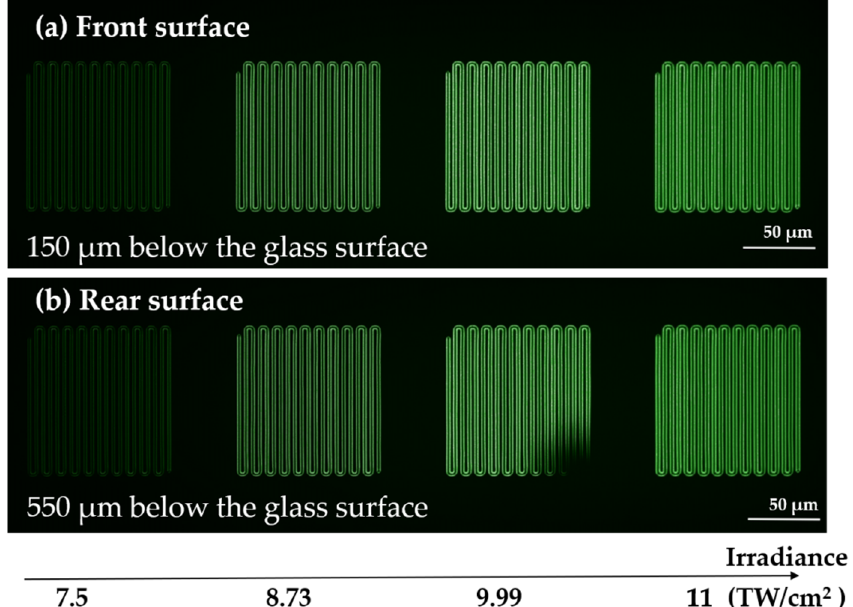
Figure 1. Microscopy fluorescence image of ARGOi glass sample (excitation at 365 nm) of laser- inscribed structures for the different writing irradiances at two different depths: ( a ) structures at 150 µm below the glass front surface, ( b ) structures at 550 µm below the glass front surface, and at 150 µm from the glass rear surface.